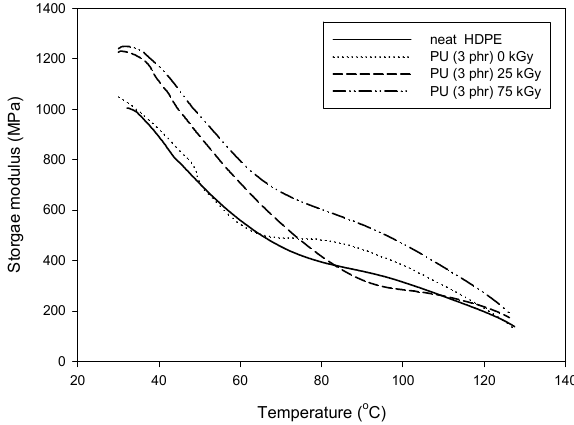
Figure 5. Storage modulus of PU (3 phr)/HDPE composite at various absorption doses.